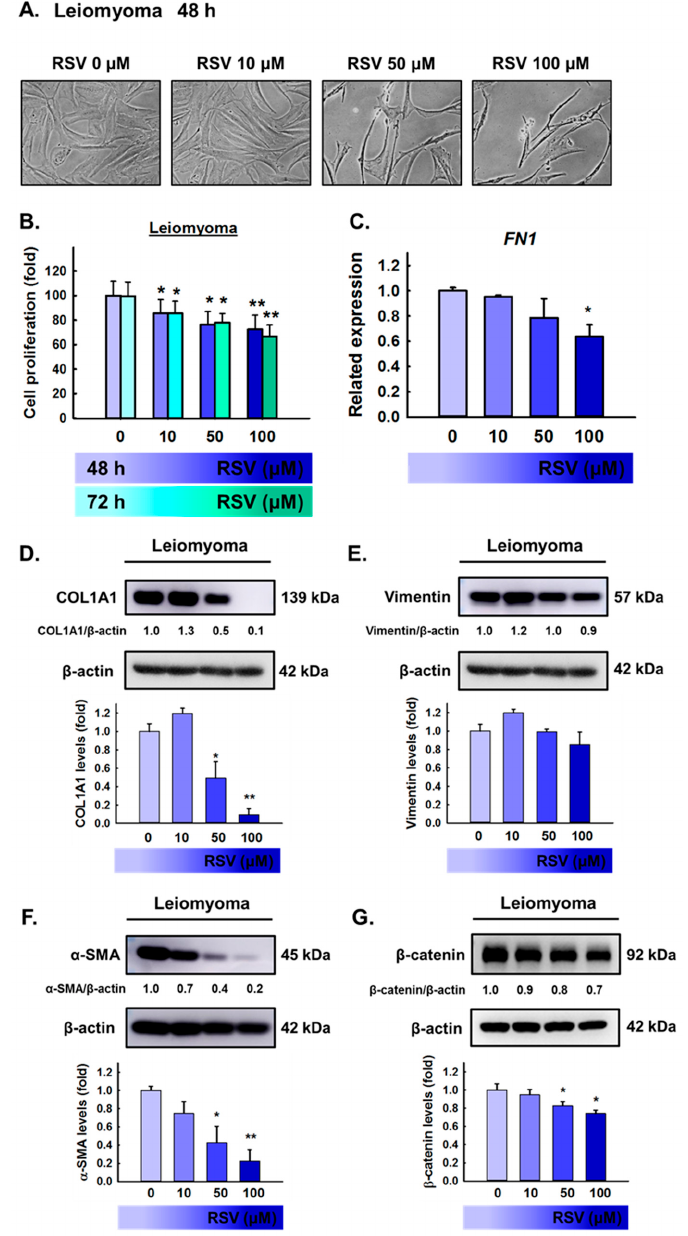
Figure 4. Cytotoxic e ff ects of resveratrol (RSV) on primary human leiomyoma cells. Leiomyoma cells were exposed to either vehicle (dimethyl sulfoxide; DMSO) or RSV (10–100 µ M) for 48 h or 72 h. ( A ) Morphology of leiomyoma cells after the indicated treatment (magnification, ×200). ( B ) Cell proliferation was measured using a 3-(4,5-dimethylthiazol-2-yl)-2,5-diphenyltetrazolium bromide (MTT) assay. ( C ) RNA samples were isolated from leiomyoma cells treated with RSV (0–100 μ M) and subjected to quantitative reverse transcription–polymerase chain reaction (qRT–PCR) using primers specific for fibronectin ( FN1 ). ( D – G ) Leiomyoma cell lysates were separated using sodium dodecyl sulfate polyacrylamide gel electrophoresis (SDS–PAGE) and analyzed using Western blot with anti-COL1A1, vimentin, α -SMA, and β -catenin. β -actin was used as a loading control. The values of the band intensity represent the densitometric estimation of each band normalized to β -actin. Protein quantification of COL1A1, vimentin, α -SMA, and β -catenin expression in leiomyoma cells is shown in the bar graph. The results are expressed as the means ± SD of three independent experiments; * p < 0.05, ** p < 0.001, as compared with the